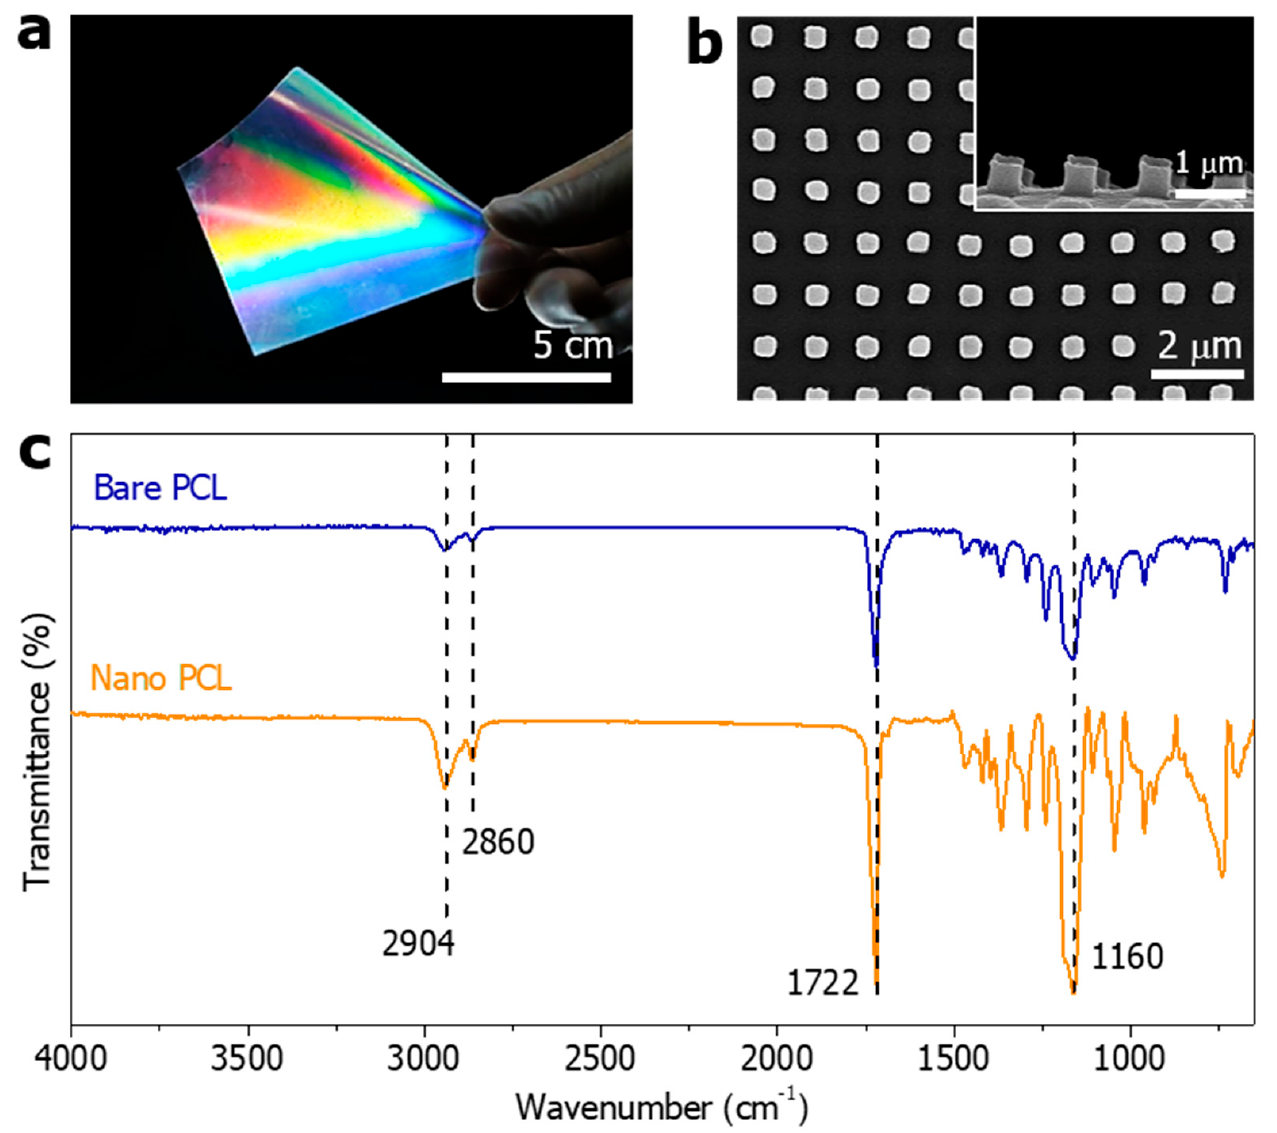
Figure 3. ( a ) Photograph of the flexible PCL film with nanopillar arrays. ( b ) SEM images of the PCL nanopillar arrays at 0 °C demolding temperature. ( c ) FT-IR spectrum of the bare PCL and nanopillared PCL.